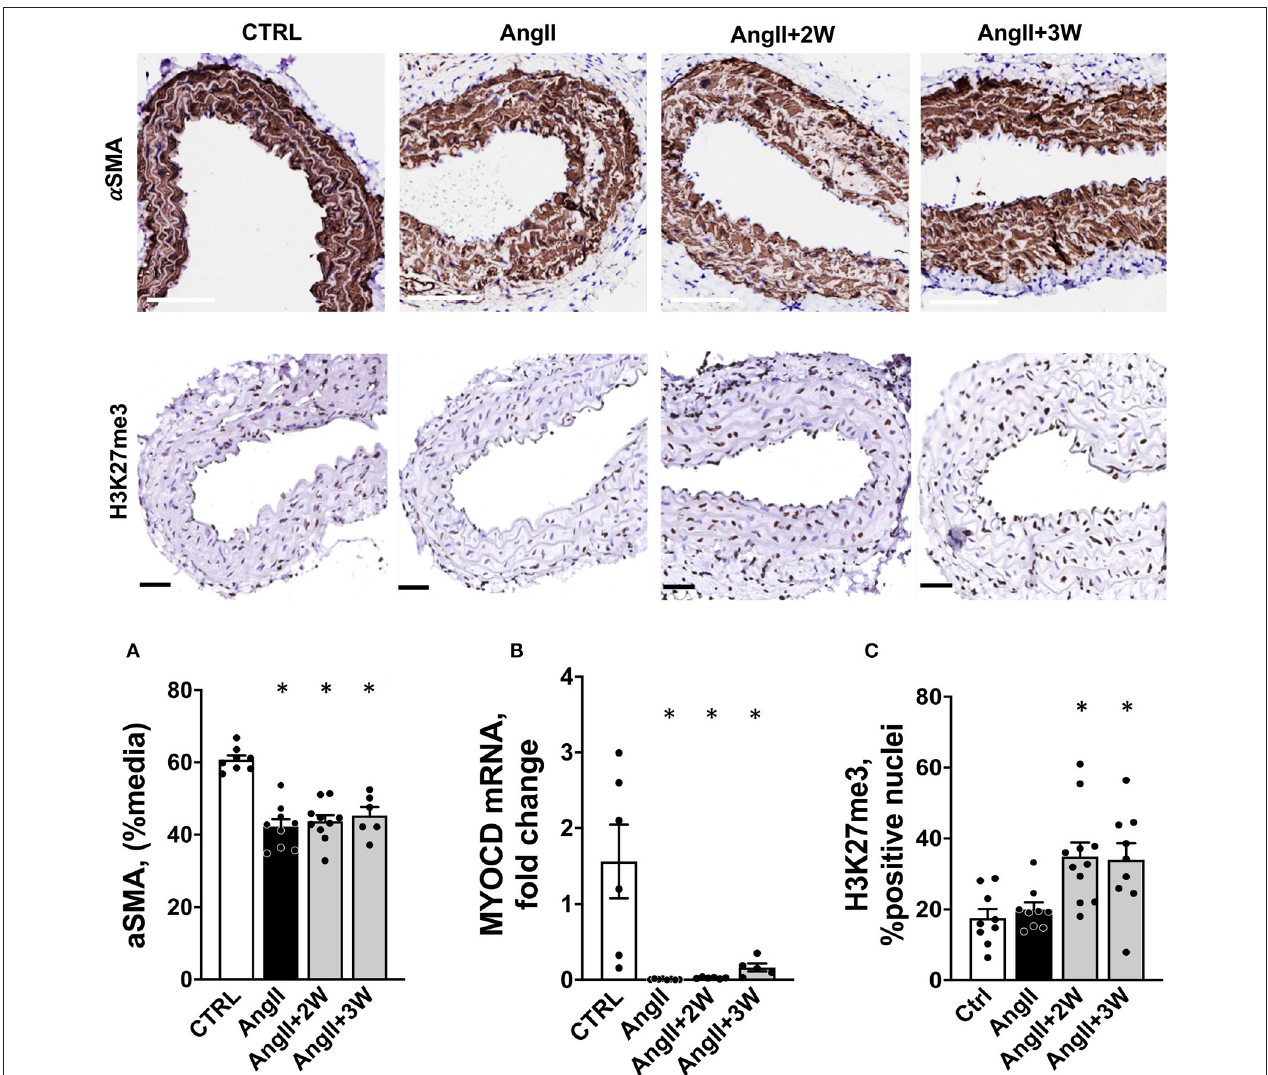
FIGURE 5 | Coordinated regulation of Alpha-Smooth Muscle Actin, its transcription factor Myocd and histone trimethylation in aortic tissue from the Ang II “memory” model. (A) Sustained down regulation of α SMA protein in aortic tissue from a replication cohort by immunostaining (white bar = 100 µ m). n = 33; * = p < 0.05, one way ANOVA followed by Dunett’s multiple comparison test. (B) Myocd mRNA expression by RTqPCR in mouse aortas from a replication cohort, n = 26; * p < 0.05, one way ANOVA followed by Holm’s-Sidak comparison test. (C) H3K27me3 staining and quantification in paraffin-embedded sections of aortas, expressed as % of positive nuclei (black bar = 50 µ m), n = 39; * p < 0.05, one way ANOVA followed by Dunett’s multiple comparison